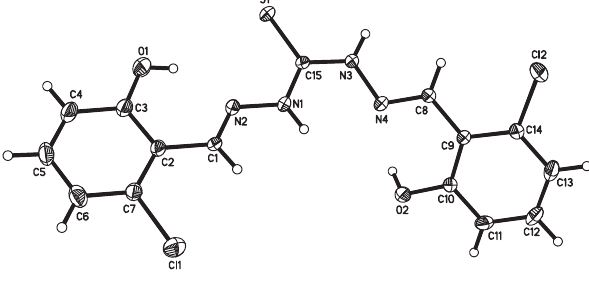
Table 1: Data collection and handling.